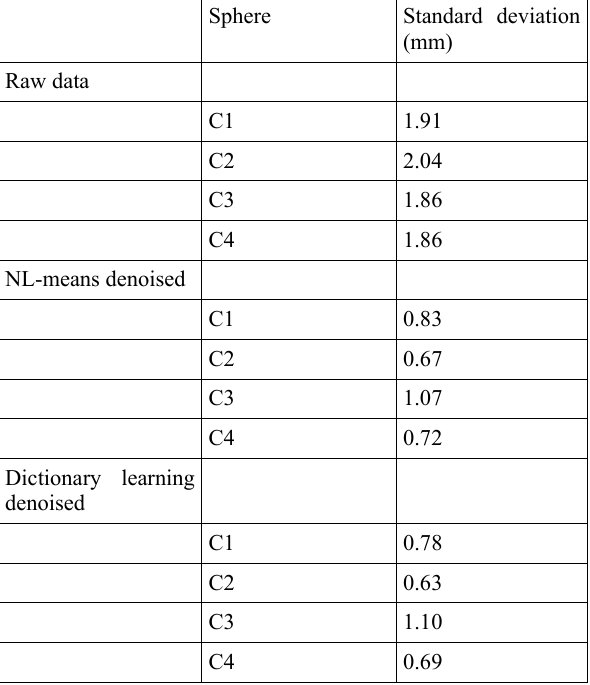
Table 1: results of denoising: raw data, NL-means denoised spheres and Dictionary-learning denoised spheres.